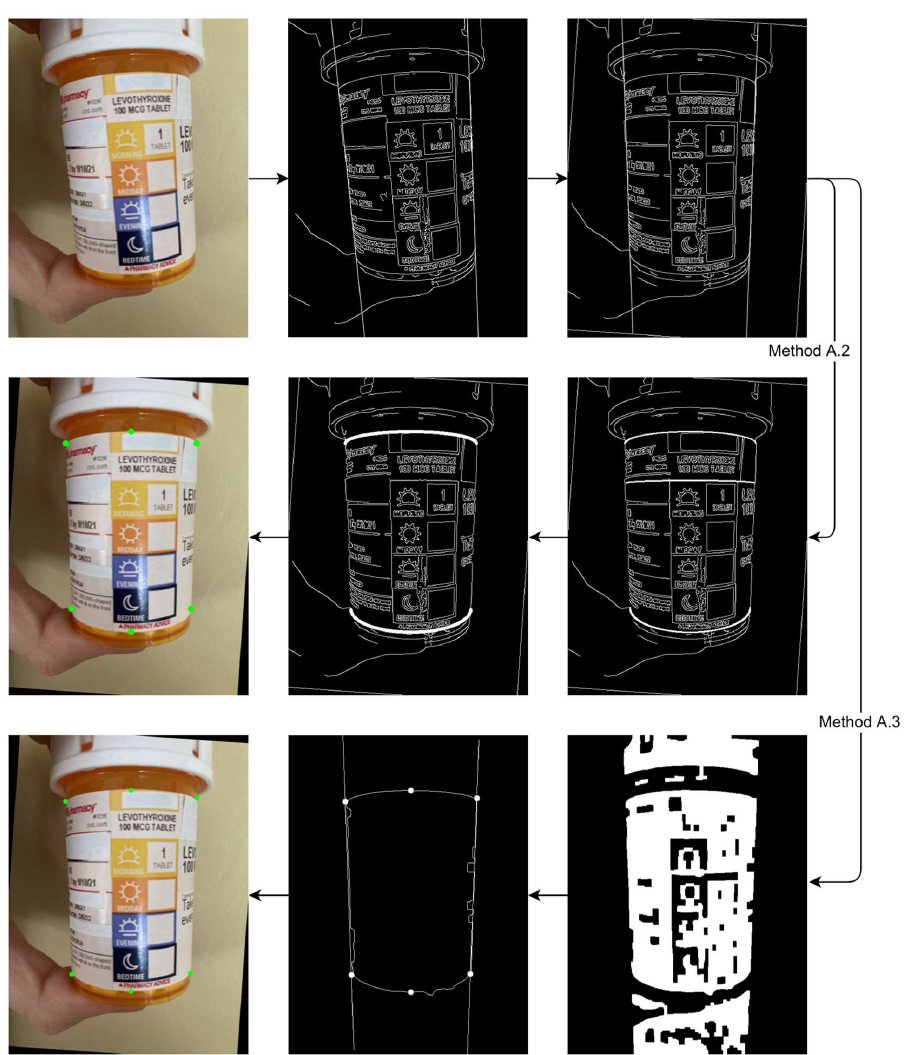
Figure 4. Key points extraction using traditional Computer Vision.